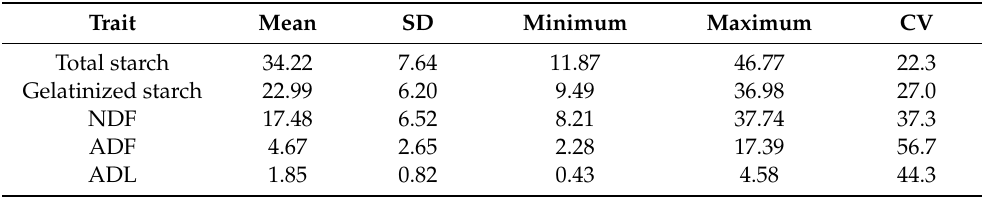
Table 3. Chemical composition (g / 100 g DM) obtained by reference analyses of dry dog food samples ( n = 81) included in this study. Trait Mean SD